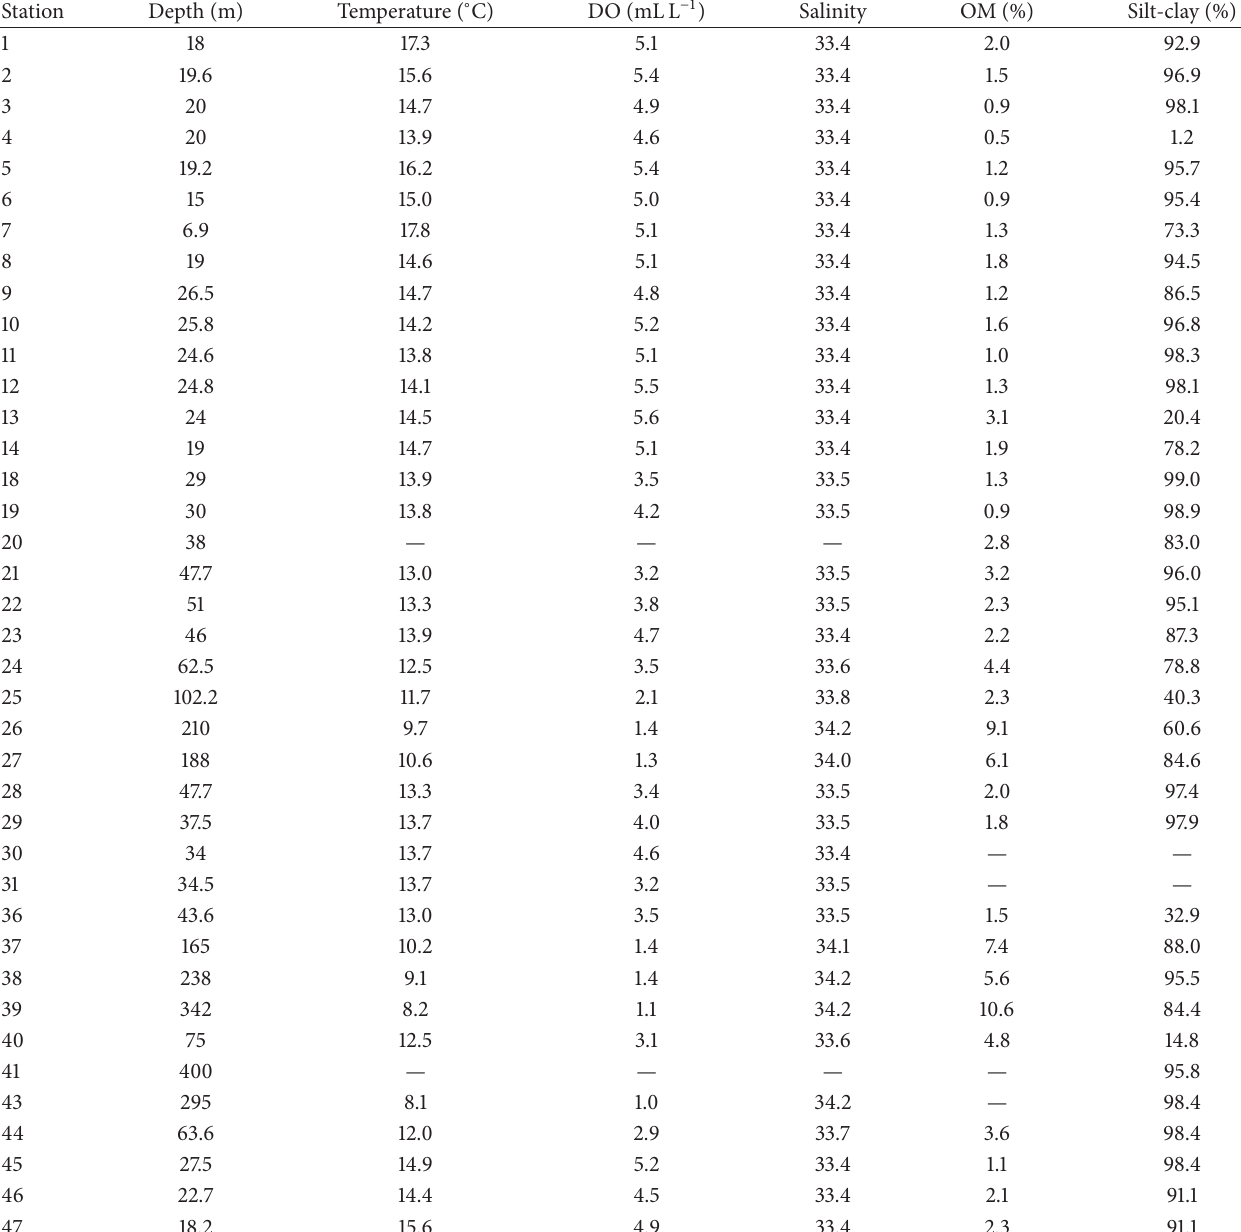
Table 1: Environmental factors measured in Todos Santos Bay, Baja California.